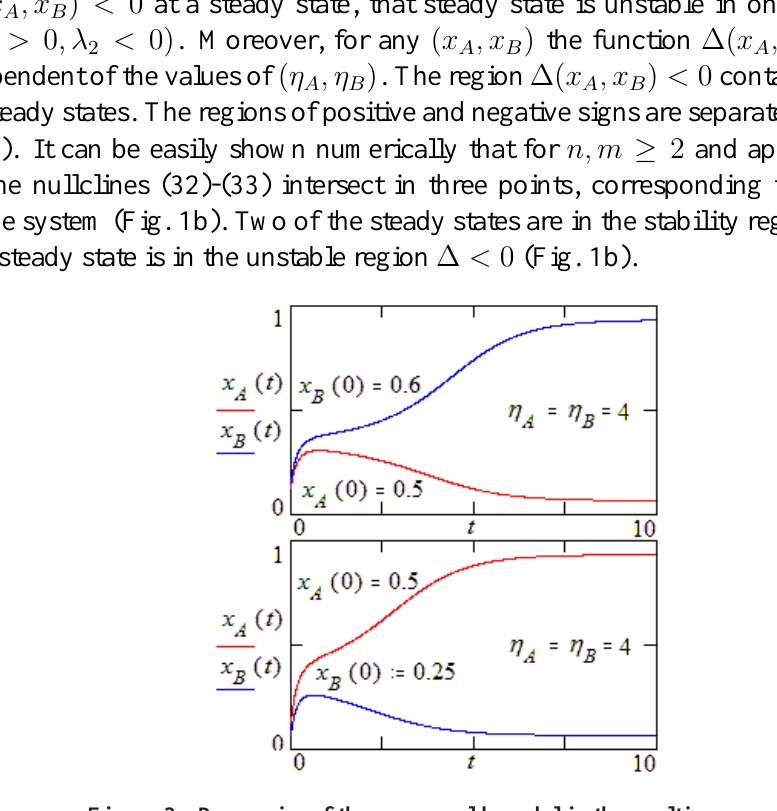
Figure 3: Dynamics of the mean-field model in the multimer